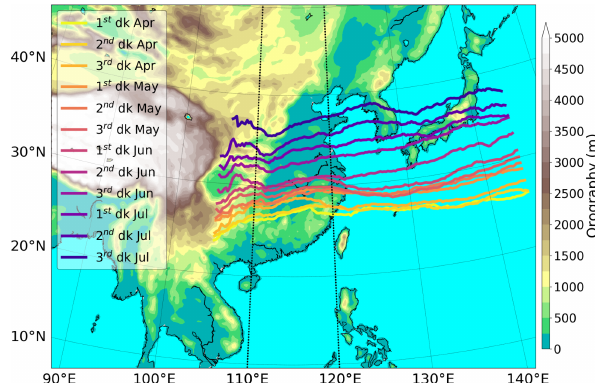
Figure 2. Dekadal (10d) mean location of EASM frontal band at 850hPa, as detected by the frontal detection algorithm (colour lines; see legend) and orography (shading; m); 110 and 120 ◦ E meridians are highlighted. Data from ERA5 1979–2018